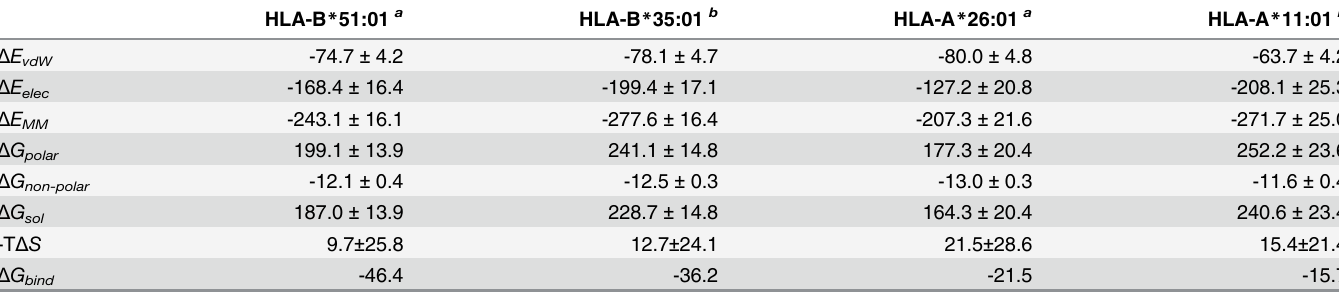
HLA alleles are a associated or b not associated with Behçet ’ s disease (BD). Data are shown as the mean ± SD, derived from independent simulations. Means within a paired row (HLA-A or HLA-B alleles that are associated with BD versus that are not) followed by a different letter are signi fi cantly